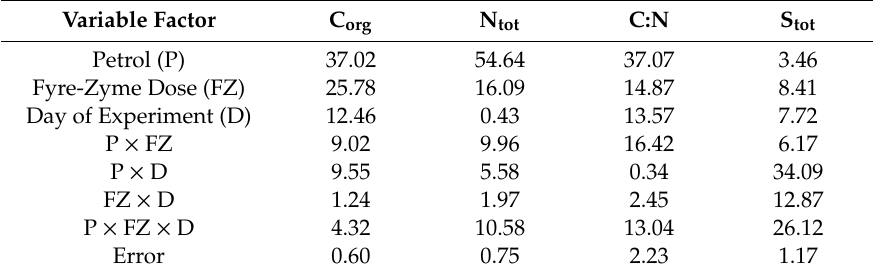
Table 4. Percentage share of observed variability factors η 2 on soil chemical parameters.